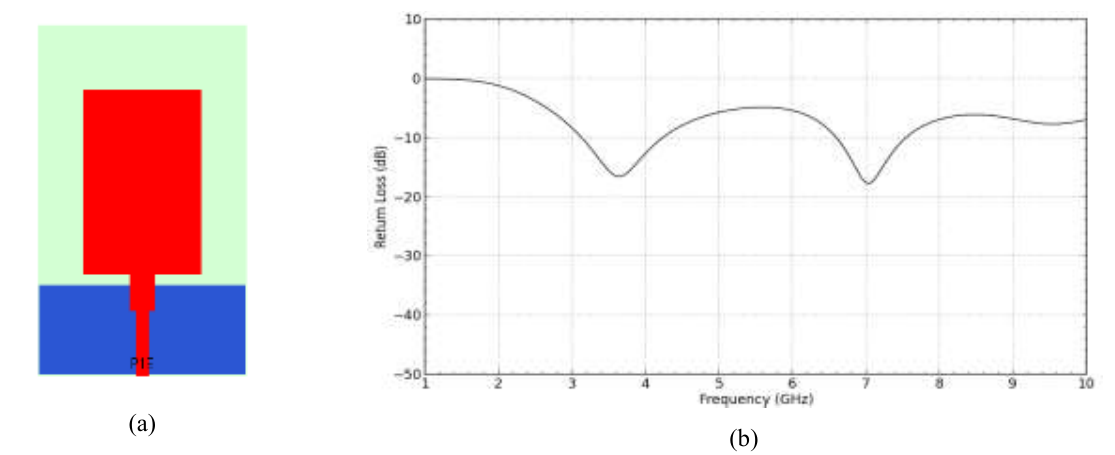
Figure 2: (a) Rectangular patch antenna and (b) its return loss (simulated)